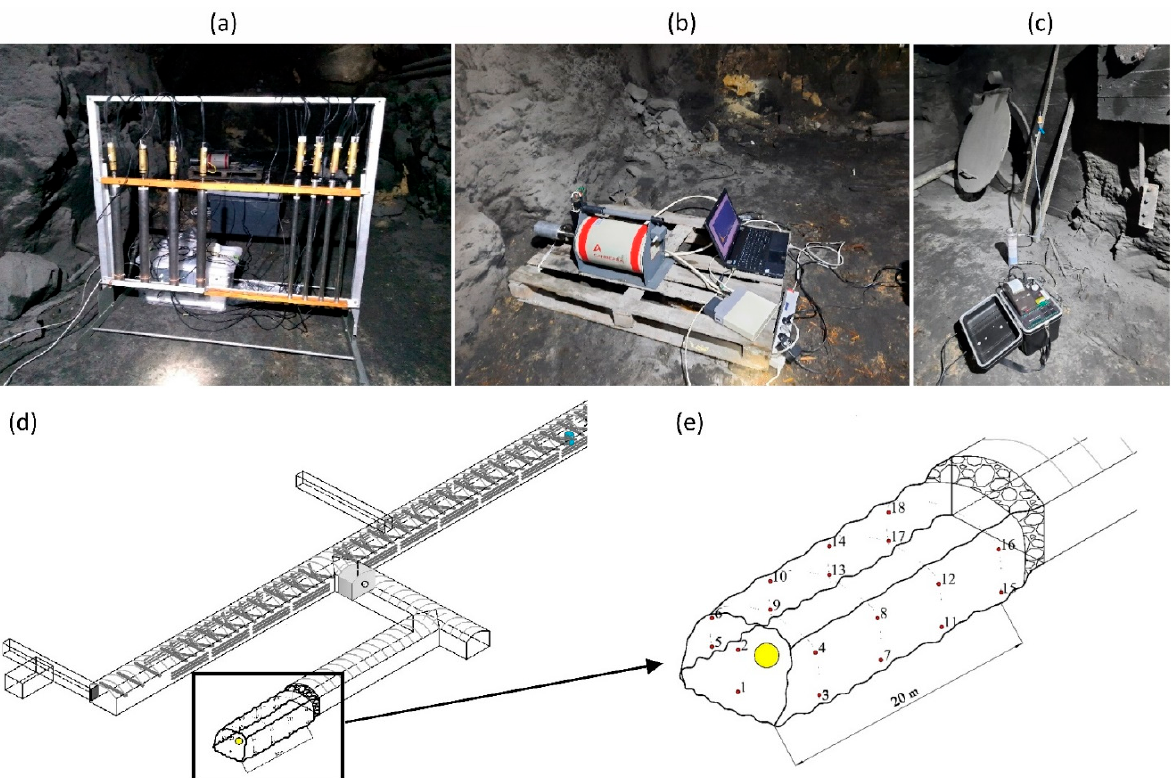
Figure 2. Measurement setup used during the measurements: ( a ) visible flat tray of helium counters placed vertically in the stand; ( b ) HPGe spectrometer; ( c ) RAD7 detector; ( d ) scheme of the workings where the research area was located; ( e ) enlarging the research area with the sampling site marked for laboratory analysis (the yellow dot marks the location of the measuring devices).